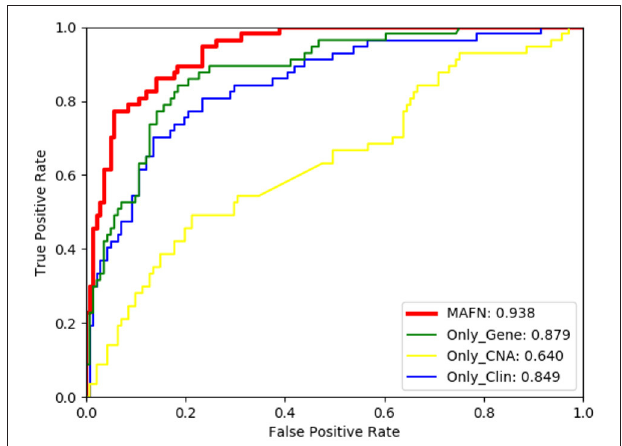
FIGURE 4 | Comparison of ROC curves of multimodal affinity fusion network (MAFN) with different modality data.